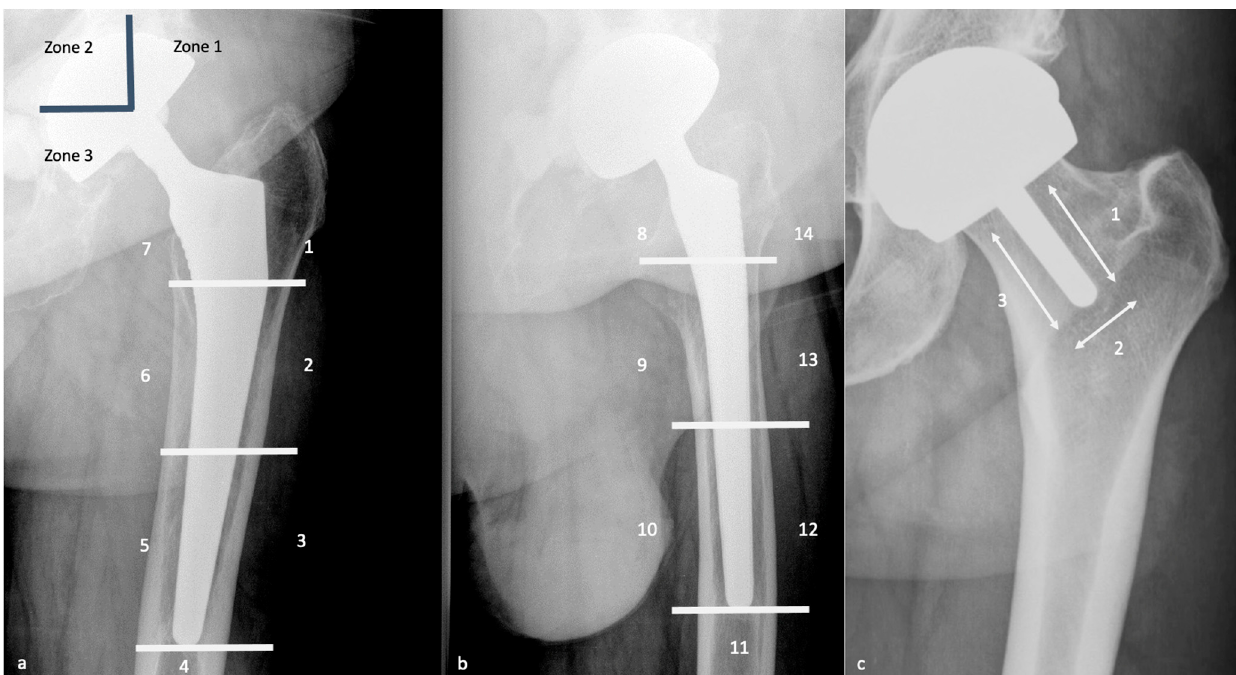
Figure 11. Acetabular and Femoral Zones to be described for osteolysis. The De Lee and Charnley acetabular zones and Gruen 1–7 femoral zones are shown on ( a ) an anteroposterior hip view, the Gruen 8–14 femoral zones on ( b ) a profile hip radiograph. The three zones to consider for femoral stem in resurfacing arthroplasties are shown on ( c ) an anteroposterior hip radiograph.